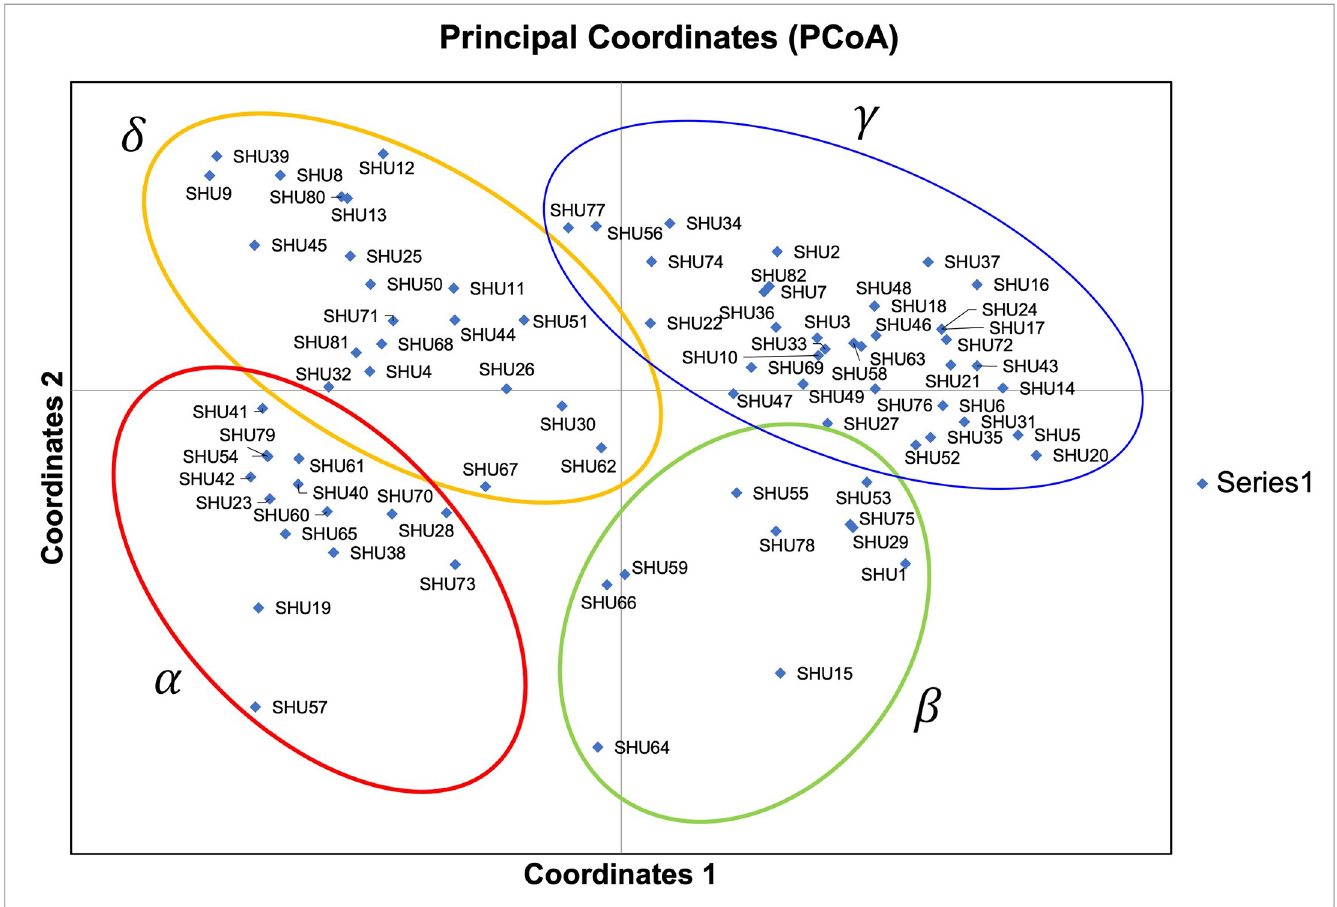
Fig 1. Principal coordinates analysis of Hume’s pheasant ( Syrmaticus humiae , Hume 1881) captive population at the Doi Tung Wildlife Breeding Center. Detailed information for all Hume’s pheasant individuals is presented in S2 Table.